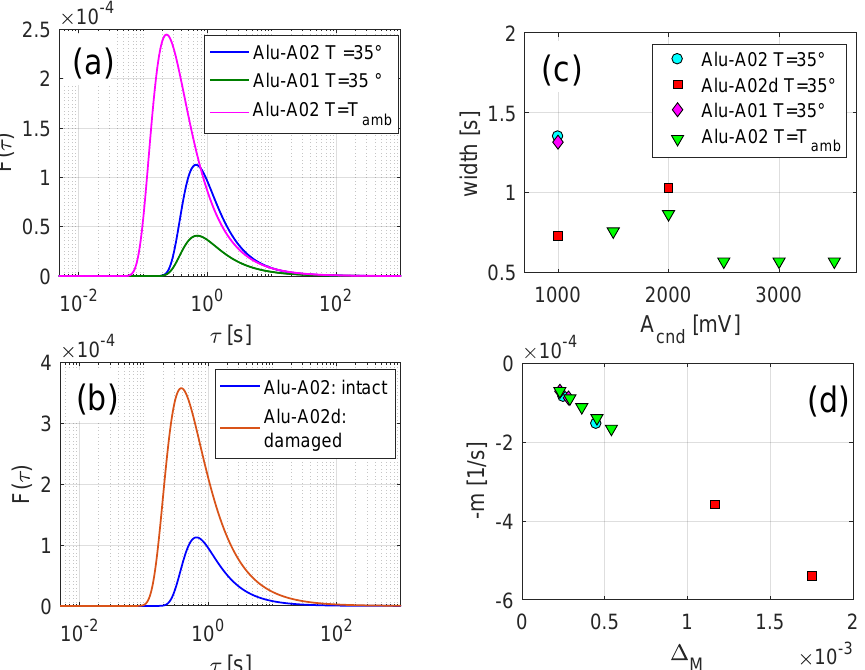
Figure 10. Effects of temperature variations and distributed damage in Al samples (Alu-A01 and equivalent). ( a ) Distribution of relaxation times for samples tested at different temperatures; ( b ) Distribution of relaxation times for sample with and without distributed damage; ( c ) Width vs. conditioning amplitude; ( d ) slope m vs. jump ∆ M during